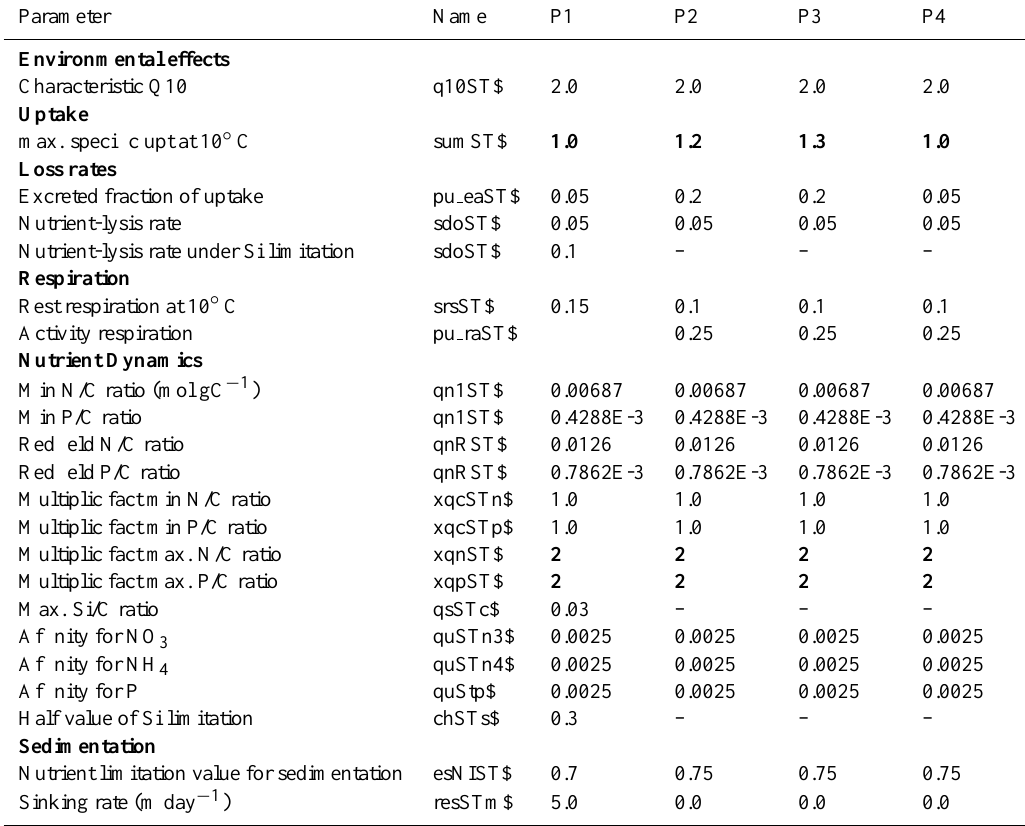
Table 1. Parameters of the phytoplankton functional groups. P1 = diatoms, P2 = nanoalgae, P3 = picoalgae, and P4 = dinoflagellates. The parameters that have been changes from the standard ERSEM version 11 are indicated in bold. Parameter names used follow the nomenclature described in Blackford and Radford